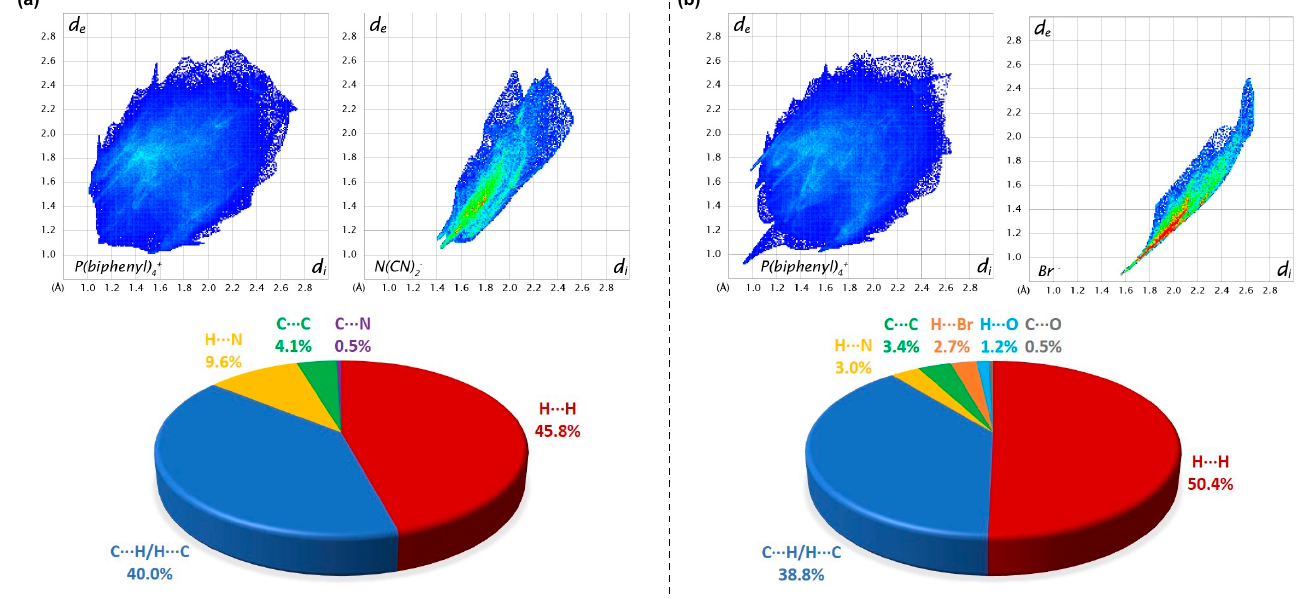
Figure 5. Fingerprint plots of tetra-biphenyl phosphonium cation and counterions (N(CN) 2 − and Br − for compounds 1 ( a ) and 2 ( b ), in addition to relative contributions of the intermolecular contacts (in percentages) to the Hirshfeld surfaces.